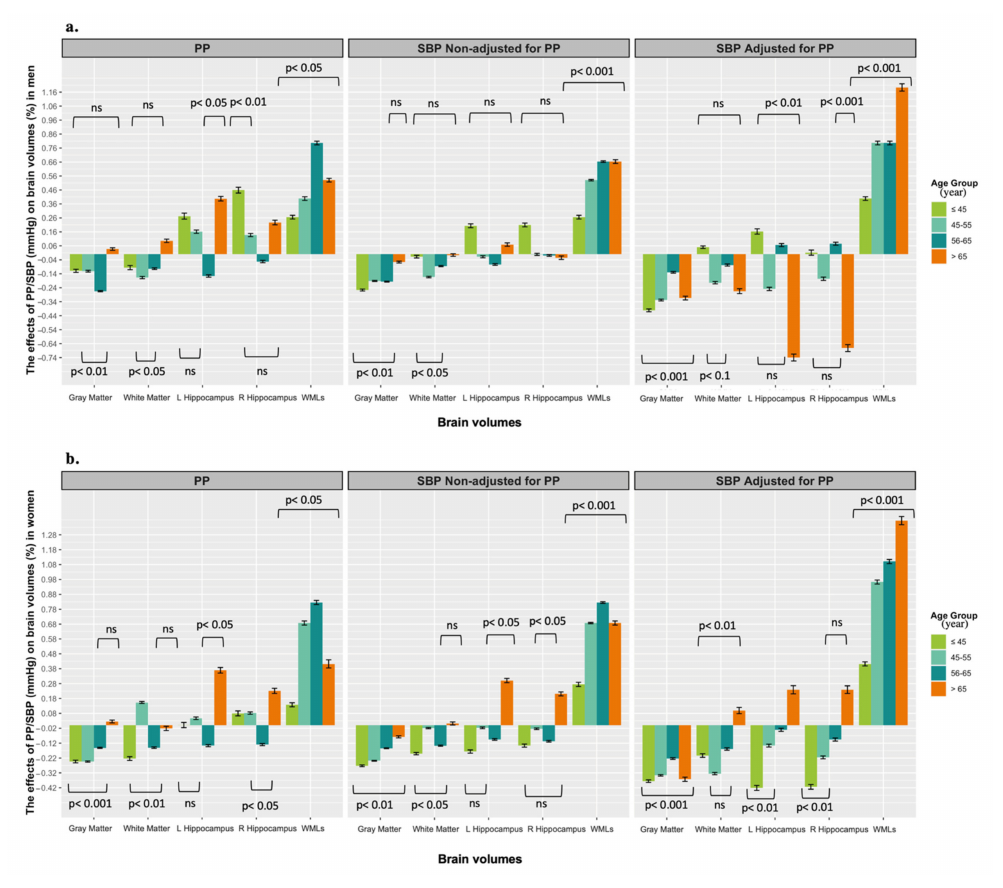
Figure 2. Proportion effects of pulse pressure (PP) and systolic blood pressure (SBP) on the brain volumes including gray matter, white matter, left hippocampus (L hippocampus), right hippocampus (R hippocampus), and white matter lesions (WMLs) across age groups in men ( a ) and women ( b ). Graphs compare the effects of PP, SBP non-adjusted by PP and SBP adjusted by PP for each brain region and WMLs in men and women. Association presented as unstandardized beta coefficient and corresponding standard error (SD). Note that for ease of interpretation, we exponentiated the coefficients to produce the proportionate effect of a 10 mmHg higher blood pressure on mean brain volume for each brain region and WMLs in men and women. For instance, an exponentiated coefficient of 1.1 reflects a 10% increase in mean brain